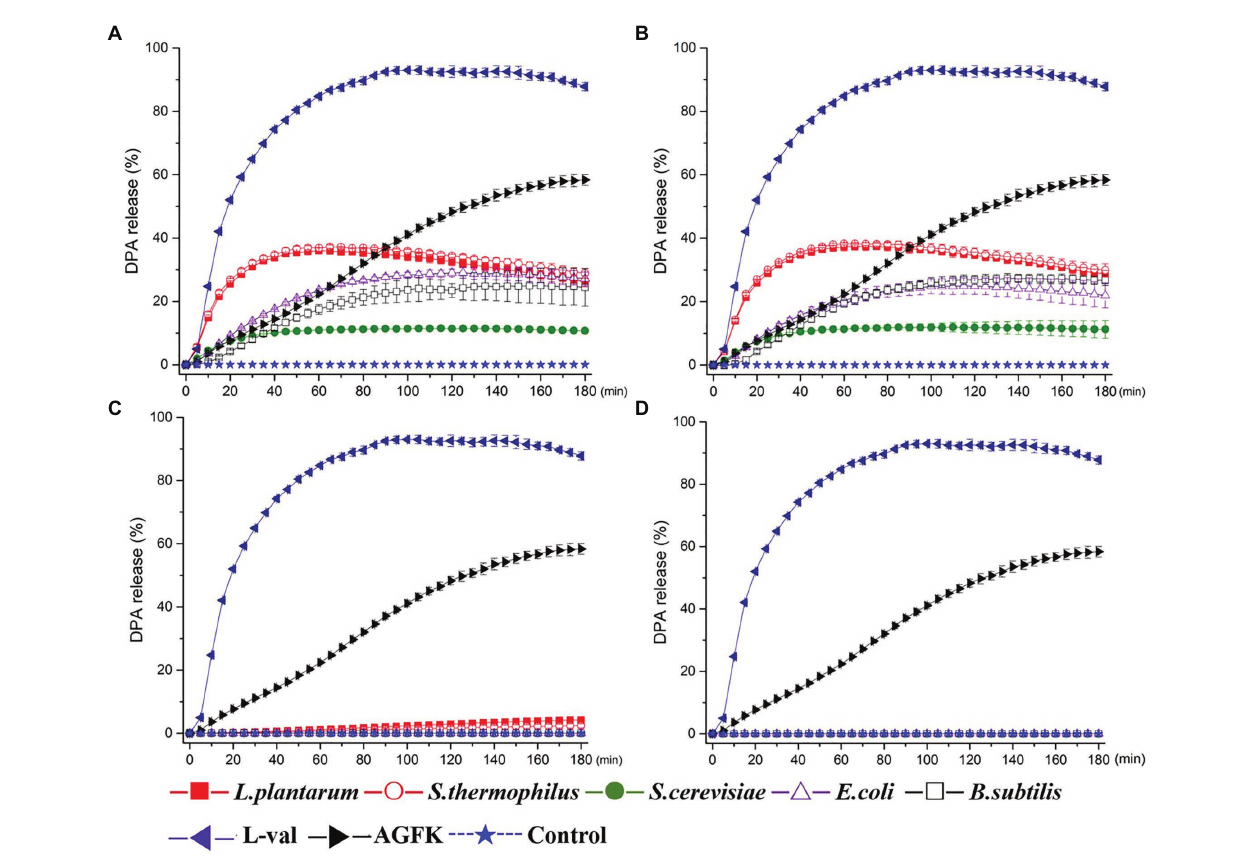
FIGURE 2 | Dipicolinic acid (DPA) release of wild-type Bacillus subtilis 168 spores with the treatments of various solutions from Escherichia coli , B. subtilis , Saccharomyces cerevisiae , Lactiplantibacillus plantarum , and Streptococcus thermophiles . (A) The treatment of supernatant from five microorganisms, respectively. (B) The treatment of filterable supernatant from five microorganisms, respectively. (C) The treatment of sediments solution from five microorganisms, respectively. (D) The treatment of ultrasonic sediments solution from five microorganisms, respectively. The treatments of L-val and AGFK were used as the positive control, and untreated spore were